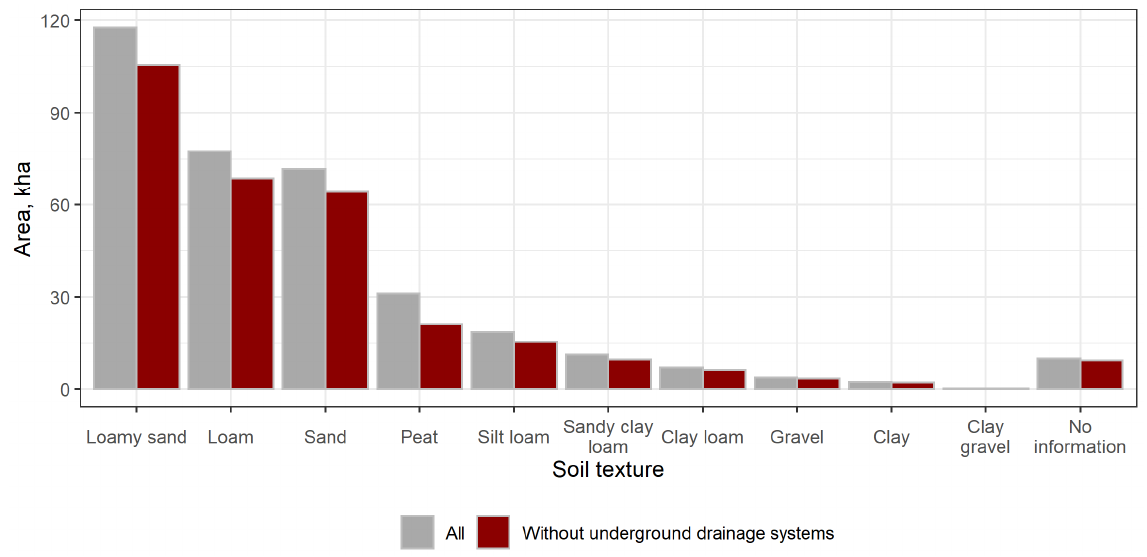
Figure 6. Area of low-value agricultural land parcels suitable for agroforestry by soil texture.